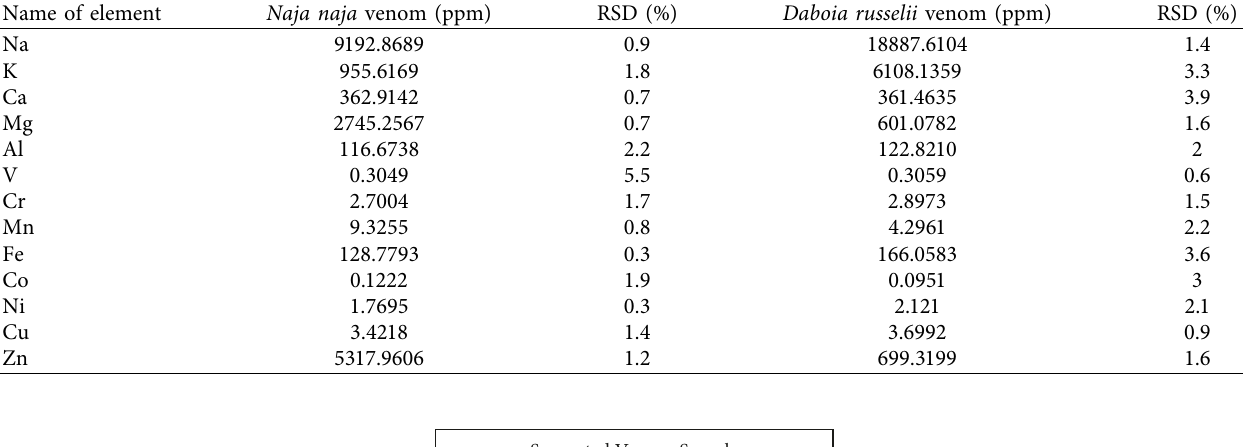
Table 3: Quantitative elemental analysis of Naja naja and Daboia russelii venoms using ICP-MS. Na, sodium; K, potassium; Ca, calcium; Mg, magnesium; Al, aluminum; V, vanadium; Cr, chromium; Mn, manganese; Fe, iron; Co, cobalt; Ni, nickel; Cu, copper; Zn, zinc; ppm , parts per million; RSD, relative standard deviation.